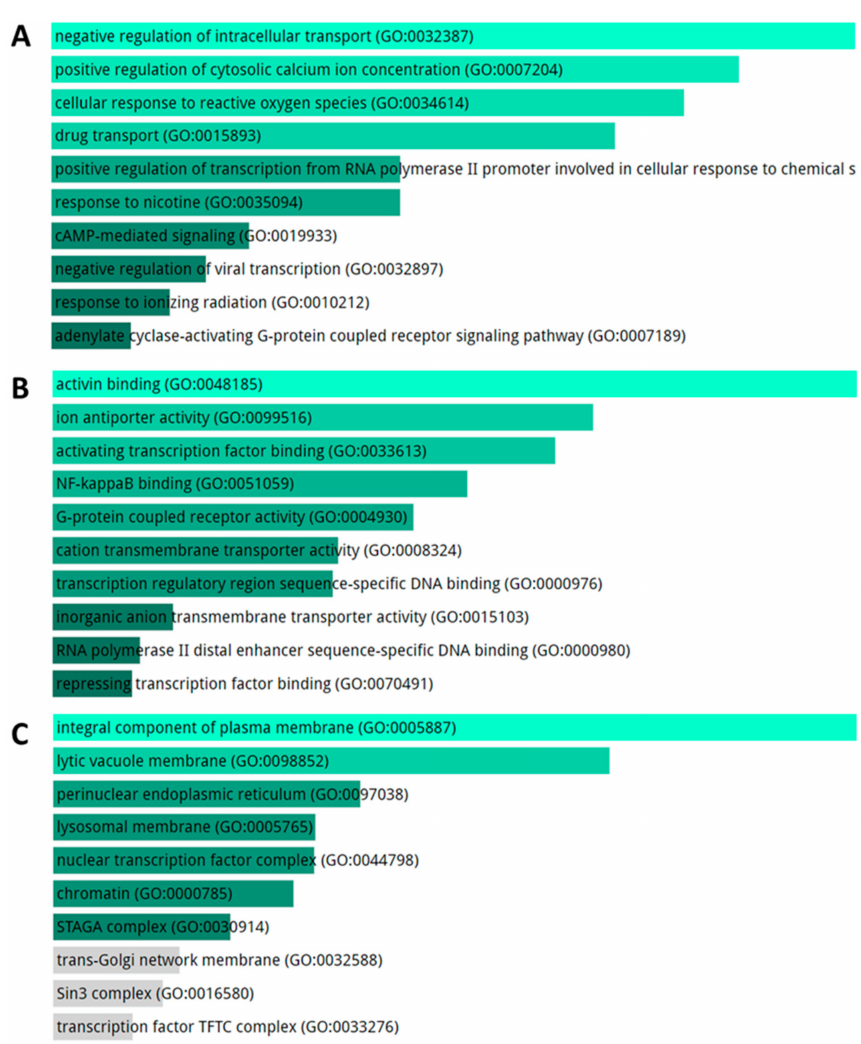
Figure 5. Analysis of pathways performed with KEGG using DE genes in SALS group compared to healthy controls. We only show top 10 KEGG terms. The significance of the specific gene-set term is represented by the length of the bar. The significance of the term is indicated by the brightness of the bar’s color (the brighter, the more significant).